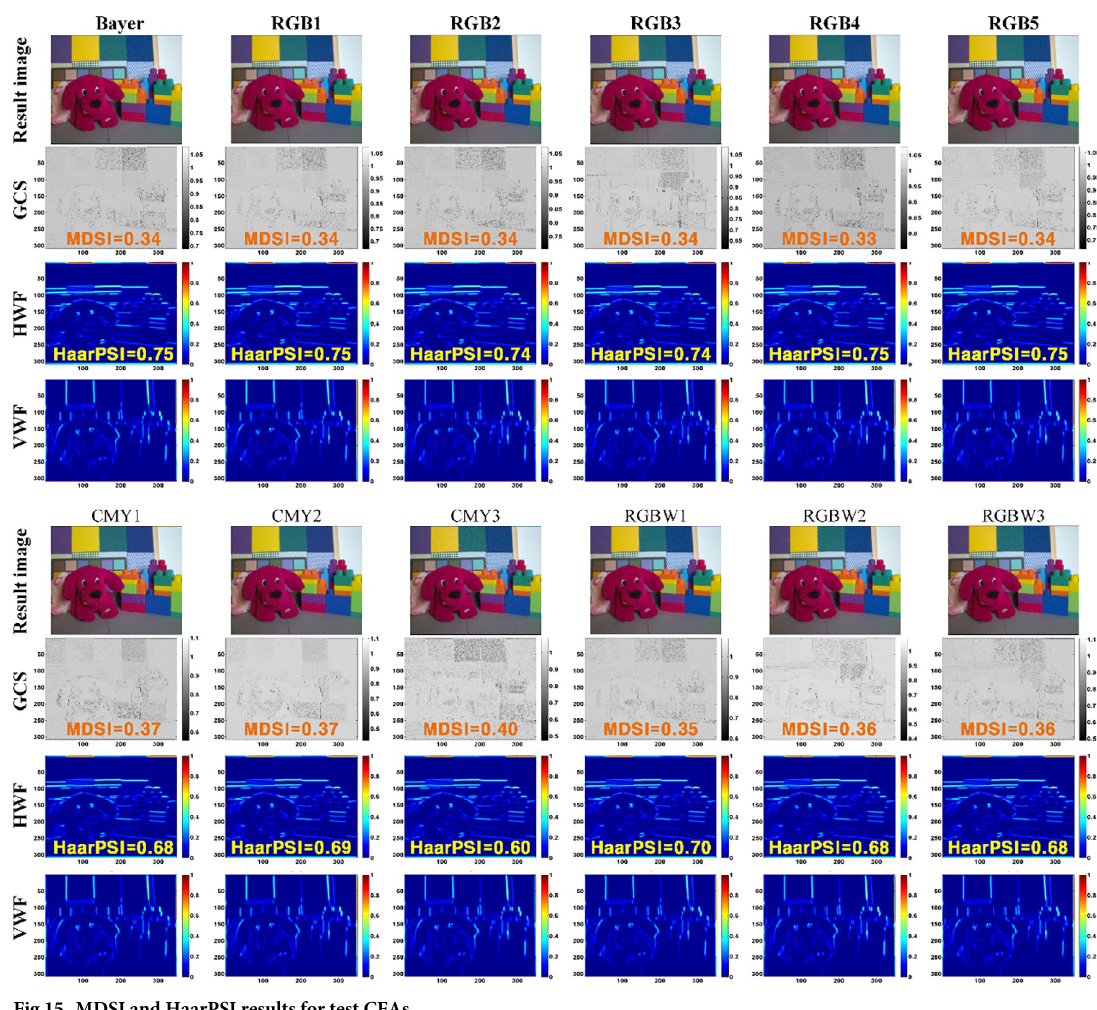
Fig 15. MDSI and HaarPSI results for test CFAs.